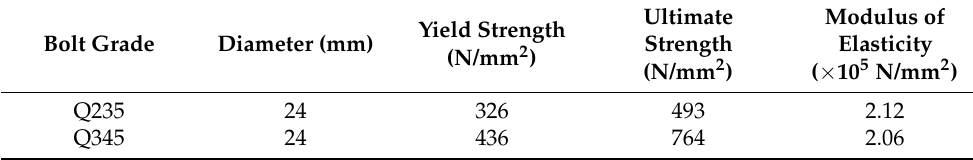
Figure 6. Tensile testing of bolt specimens. ( a ) Connection bolt; ( b ) bolt specimens damaged by ten- sion. Table 5. Mechanical properties of bolts. Table 5. Mechanical properties of bolts.